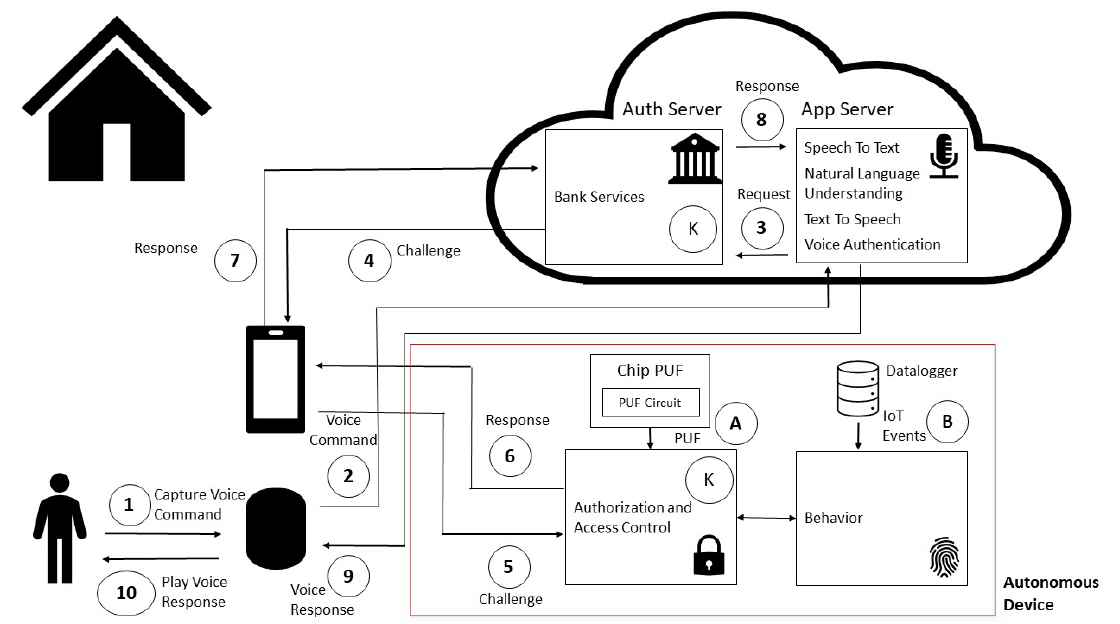
Figure 11. Proposed non-invasive authentication protocol with autonomous device in